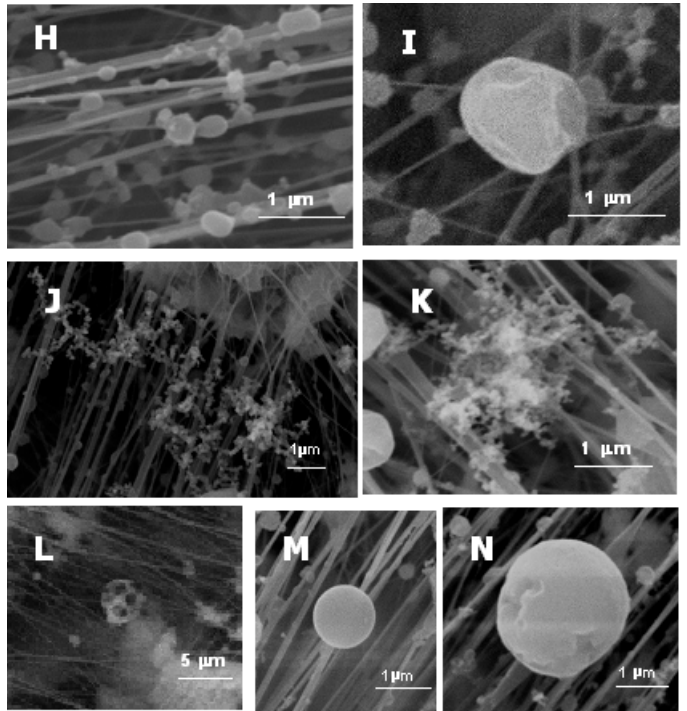
Figure 3. SEM images of suspended particulate matter: ( H , I ) sphere-like particles, ( J , K ) soot dendritic aggregates, ( L ) fuel oil particle, ( M , N ) spherical